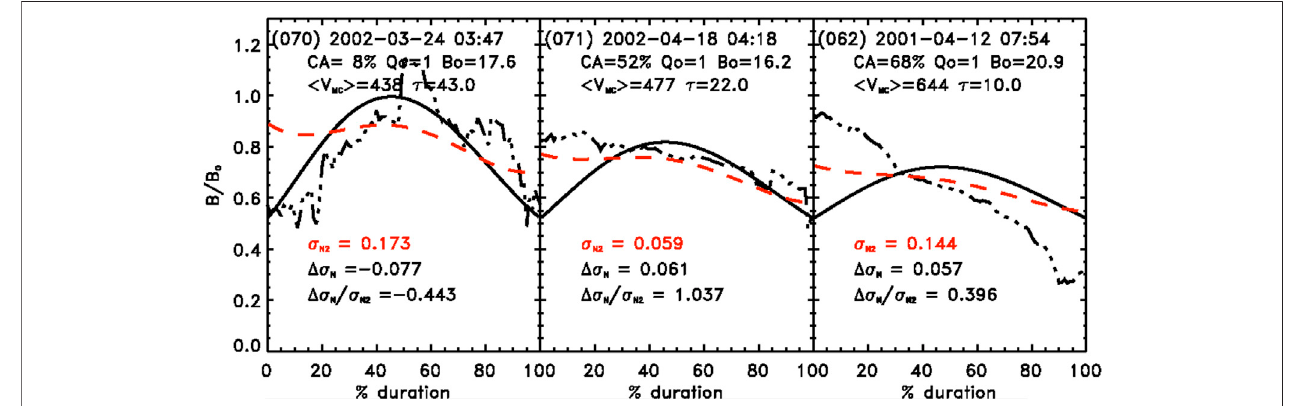
FIGURE1| Threeexamples(thecasesof#s70,71,and62of Wind MCs;seetheassociatedstartingdatesoftheseMCsonthe fi rstlineatthetopofeachpanel)of plotsof B/B 0 -pro fi les: B 0 -normalized Bobservations (blackdash-dot-dot),forcefreemodelvalues(blacksolidcurve)andmodi fi ed-modelvalues(reddashedcurvefrom Lepping et al.[10] — all asafunction ofpercent passagethroughthe MC (i.e., u in%); each pro fi le has 101 points across. In each panel thefollowing areshown: TOP OF EACH PANEL:thestarttime(year-month-dayofmonth)hour:minute(UT), CA ( (cid:1) | Y 0 |/ R 0 in%),Quality( Q 0 ), B 0 (innT),averageplasmaspeedwithintheMC( < V MC > , in km s − 1 ), and duration ( τ , in hours), BOTTOM OF EACH PANEL: the values of the quantities Δσ N , σ N2 , and Δ σ N / σ N2 (see text) that are described by Lepping et al. [10]. The ratio Δσ N / σ N2 in particular is shown to be a good measure of how well the scheme is performing in general.